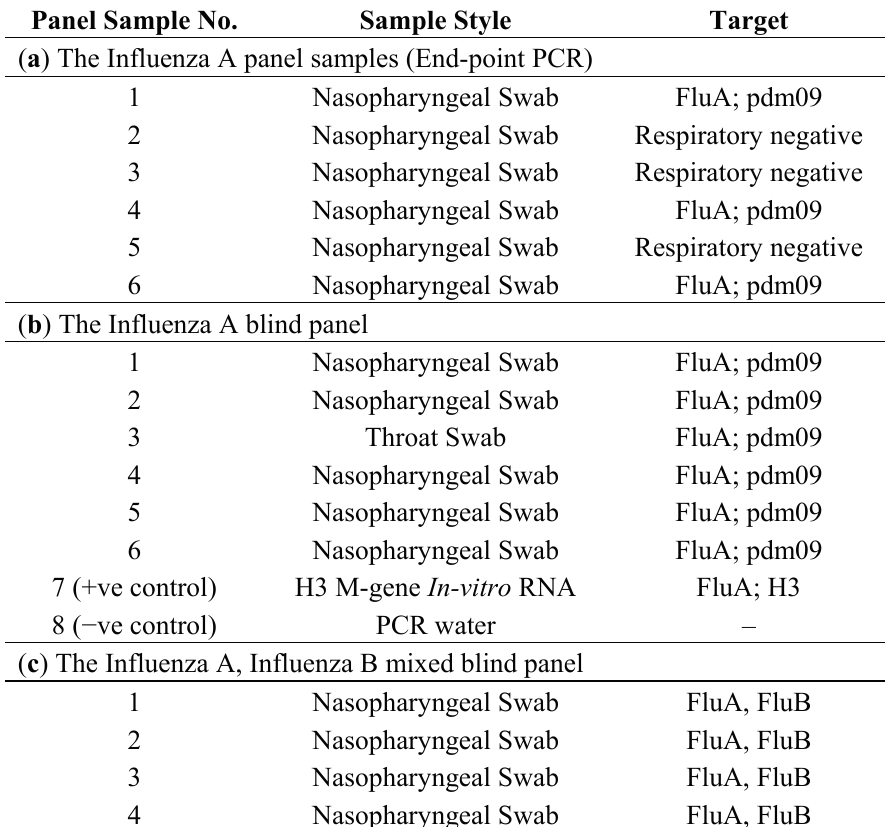
Table 1. Tabular list of the three different clinical panels used to validate the performance of multiplexed assays using the fabricated